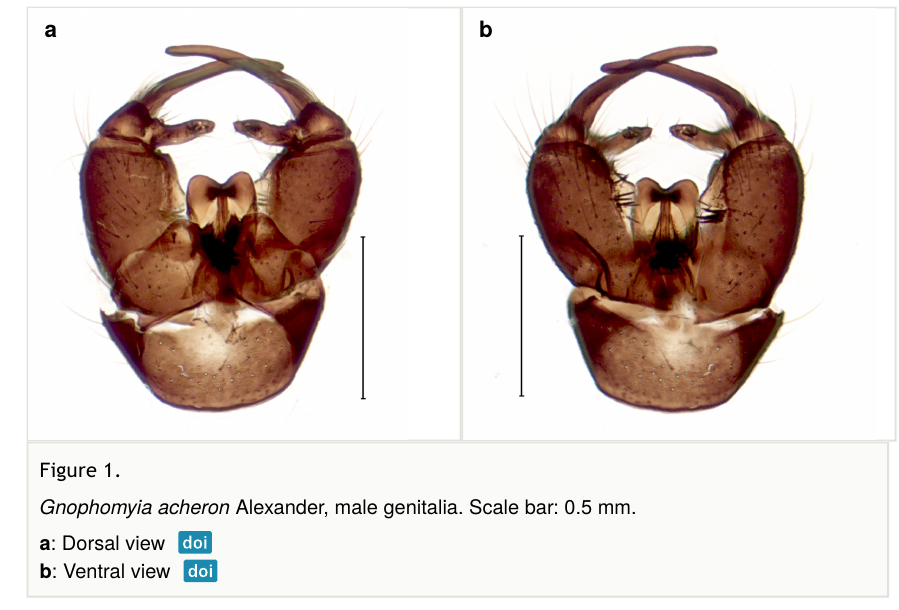
Figure 1. Gnophomyia acheron Alexander, male genitalia. Scale bar: 0.5